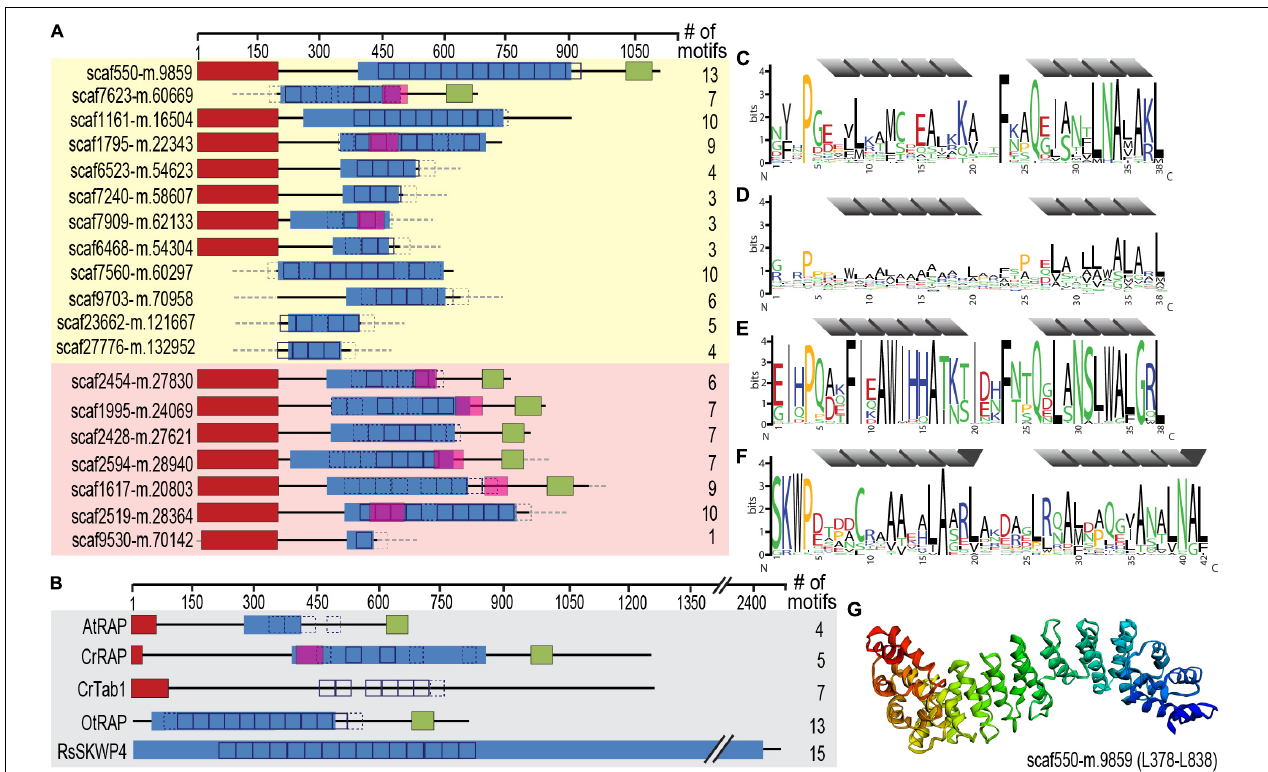
FIGURE 6 | Identification of an expanded family of putative OPR expression regulators targeted to the chromatophore (and mitochondrion) in P. chromatophora. (A) Domain structure of 12 OPR-containing import candidates identified by MS (yellow background) and further 7 predicted import candidates with a similar domain structure (red background). The number of motif repeats identified in individual proteins is indicated. (B) Domain structure and motif repeats in (putative) expression regulators from other organisms. AtRAP, A. thaliana RAP domain-containing protein, NP_850176.1 (Kleinknecht et al., 2014); CrTab1, Chlamydomonas reinhardtii PsaB expression regulator, ADY68544.1 (Rahire et al., 2012). OtRAP, Orientia tsutsugamushi uncharacterized RAP domain-containing protein, KJV97331.1, and RsSKWP4, Ralstonia soleraceum RipS4-family effector, AXW63421.1 (Mukaihara and Tamura, 2009), appear as the highest scoring BlastP/DELTA Blast hits (in the NCBI nr database) for P. chromatophora OPR proteins. (C) 38-aa repetitive motif found in P. chromatophora import candidates. (D) OPR motif found in C. reinhardtii expression regulators (designed according to Cline et al., 2017). (E) Motif derived from O. tsutsugamushi OPR proteins. (F) 42 aa SKWP motif derived from RipS-family effectors in R. soleraceum, Xanthomonas euvesicatoria, and Mesorhizobium loti (Mukaihara and Tamura, 2009; Okazaki et al., 2010; Teper et al., 2016). Individual repeats are predicted to fold into two α -helices (gray). Red, targeting signal (crTP for P. chromatophora proteins, cTP for AtRAP and CrTab1, mTP for CrRAP); blue, PRK09169-multidomain (Pssm-ID 236394); pink, FAST-kinase like domain (Pssm-ID 369059); green, RAP domain (Pssm-ID 369838); boxes, individual repeats of the motifs shown in (C–F) ( p < e - 20 ; p < e - 10 for CrRAP and CrTab1); dashed boxes, weak motif repeats ( p < e - 10 ; p < e - 7 for CrRAP